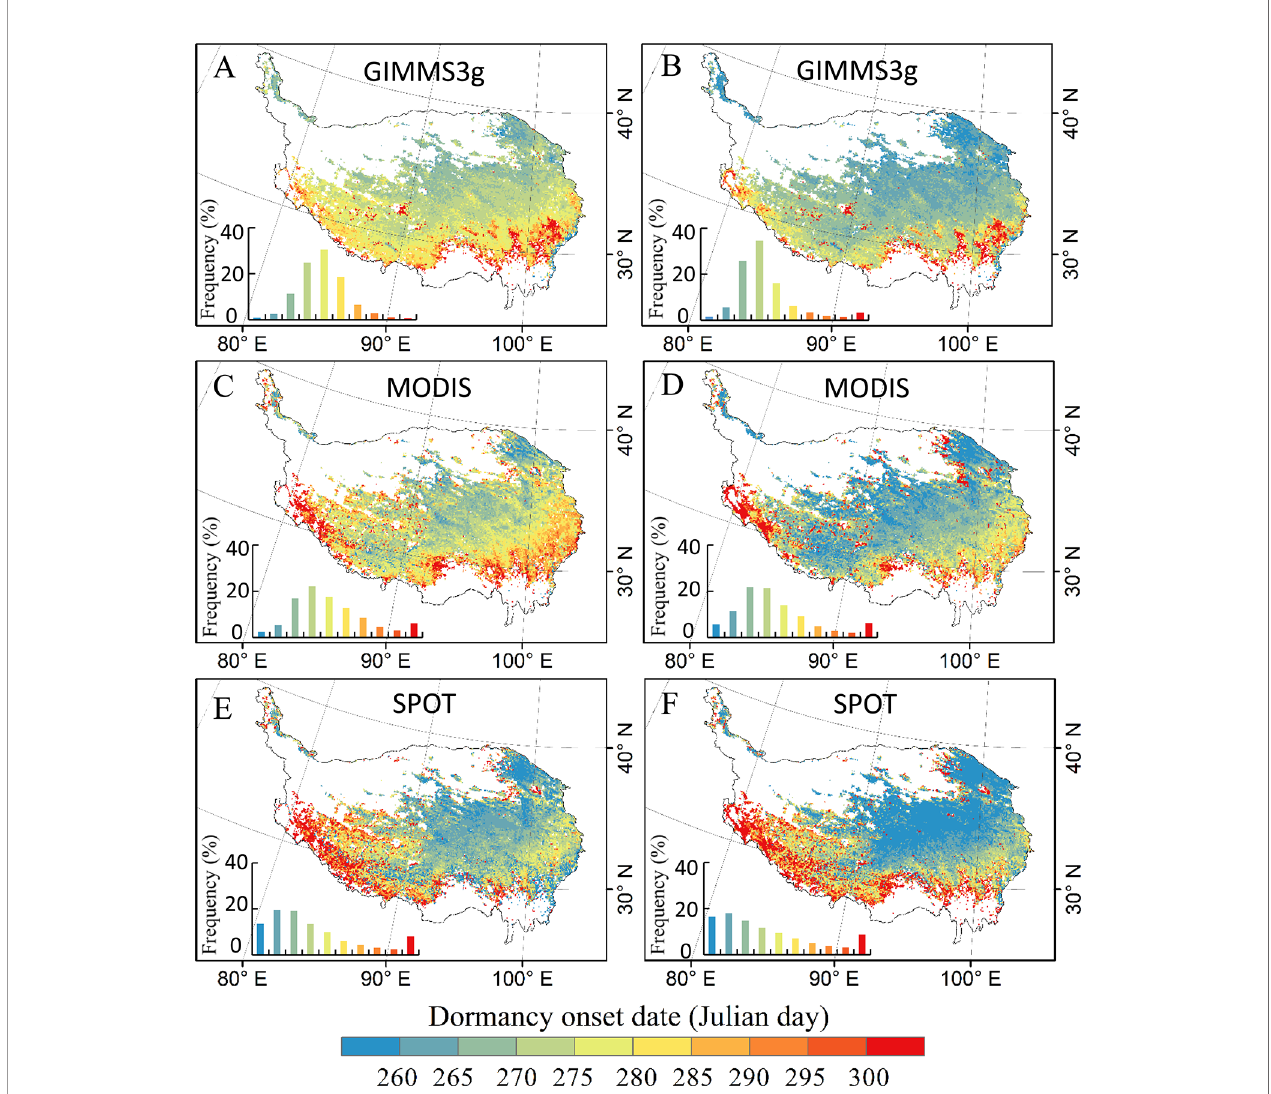
FIGURE 2 | The spatial distribution patterns of the vegetation dormancy onset date (DOD) on the Qinghai – Tibet Plateau based on GIMMS3g (Global Inventory Modeling and Mapping Studies, 1982 – 2012), SPOT (Systeme Probatoire d ’ Observation de la Terre, 1999 – 2012), and MODIS (Moderate Resolution Imaging and Spectroradiometer, 2000 – 2012) normalized differential vegetation index (NDVI) data sets determined by threshold method (A, C, E) and derivative method (B, D, F) . The left bottom of each submap displays the DOD frequency distribution in each interval of DOD indicated by the color in the legend in the